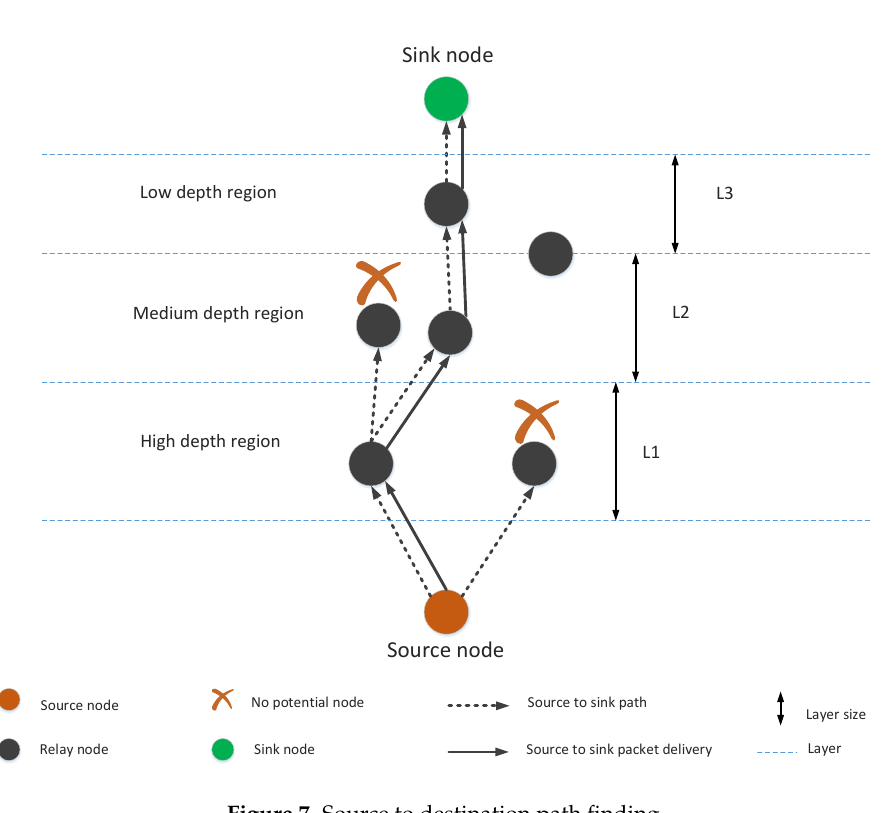
Figure 7. Source to destination path